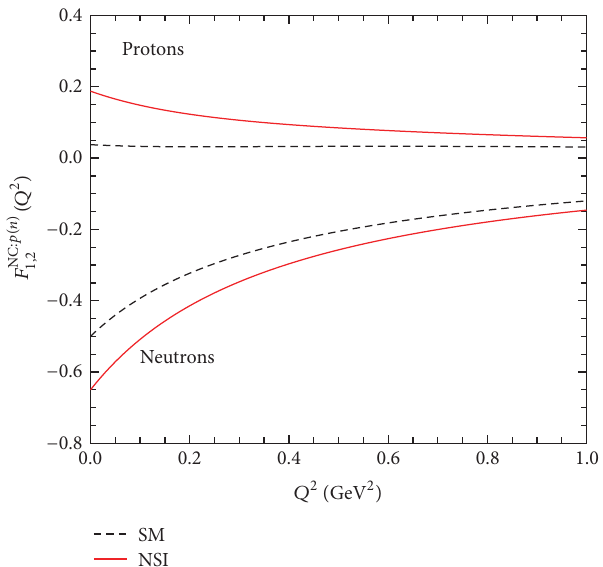
Figure 2: Comparison of the SM and NSI nucleon form factors employed in the present study (for details, see the